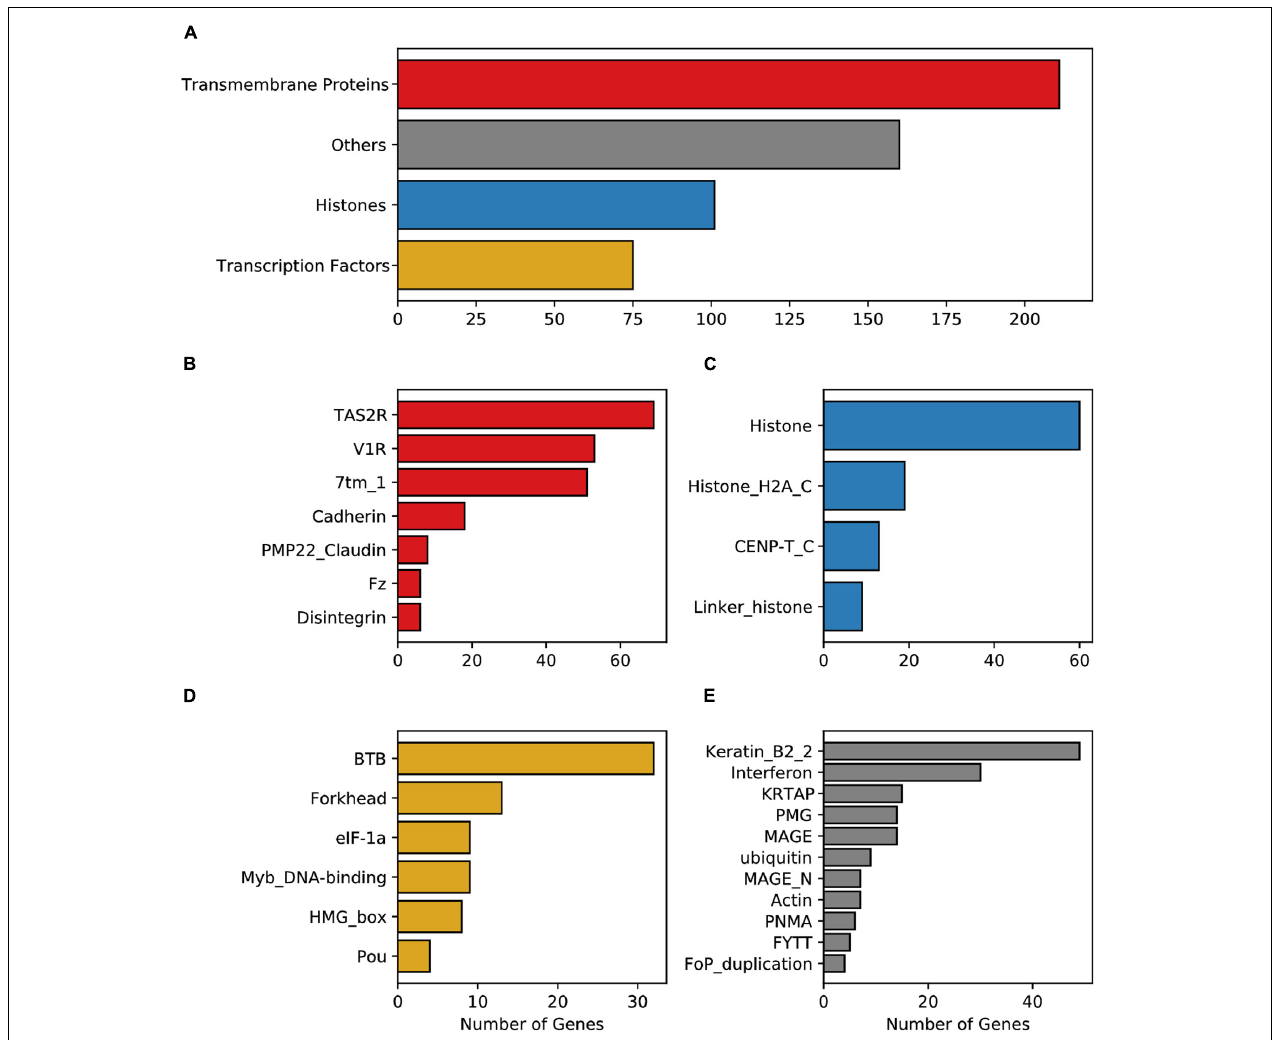
FIGURE 2 | Enrichment of the Pfam protein domains in mouse IG proteins. (A) Enriched domains of proteins grouped into four main classes, transmembrane proteins (red), histones (blue), transcription factors (yellow), and others (gray). Enrichment of domain terms was calculated with a significant background list associated with the Pfam domain and p-adjusted values above 0.05. (B) Pfam domains grouped in the transmembrane proteins class, (C) Pfam domains grouped in the histone class, (D) Pfam domains grouped in the transcription factors class, (E) Pfam domains considered as others